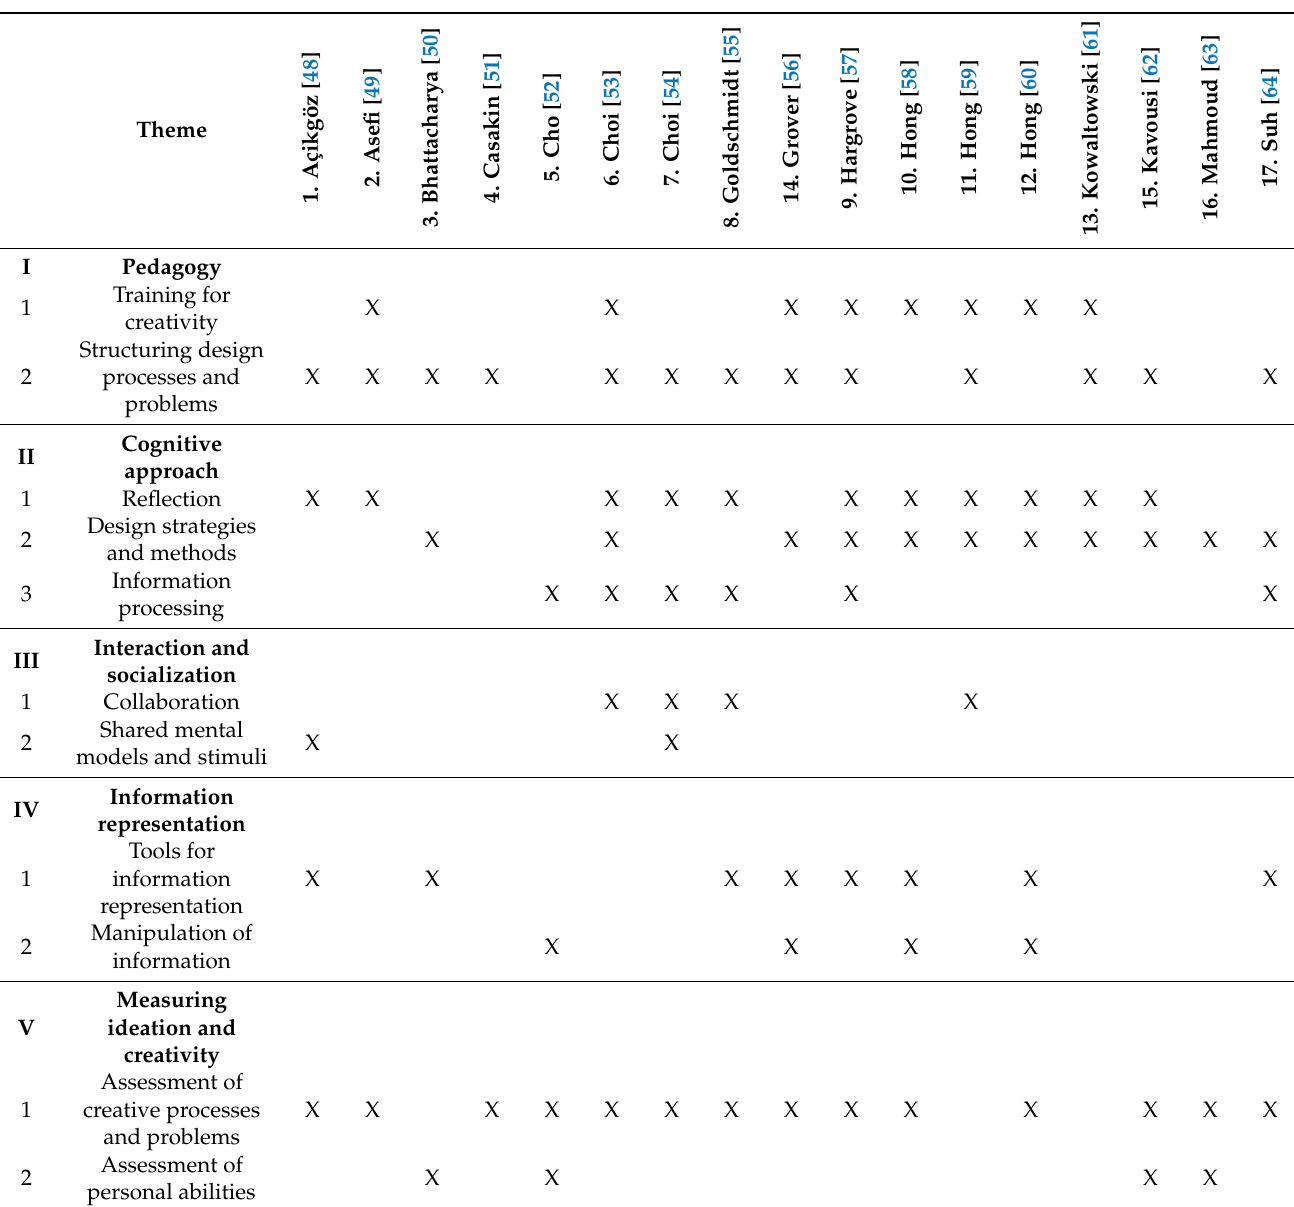
Table 3. Categories and themes emerging for the selected